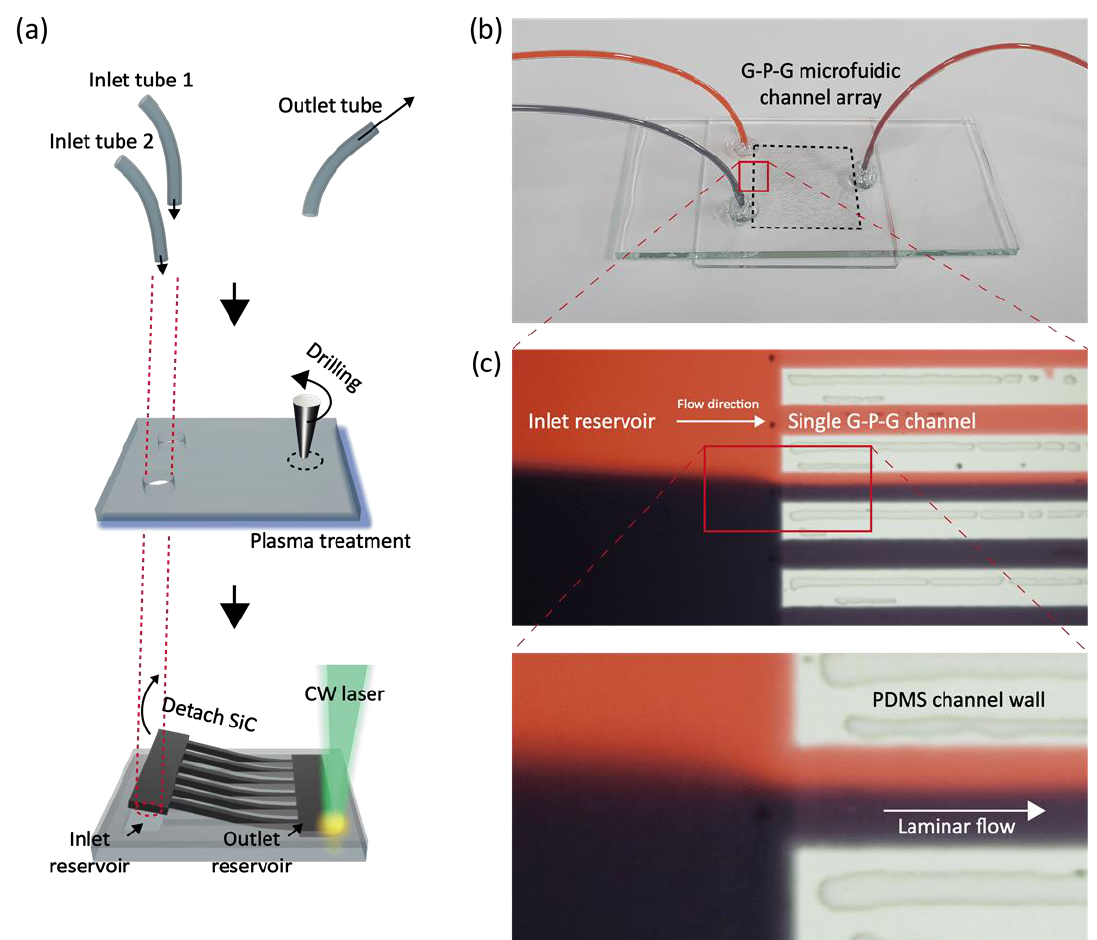
Figure 5. ( a ) concept illustration of microdevice fabrication, ( b ) microdevice images with tubes of inlet and outlet, ( c ) 20X magnified optical microscopy images of multiple channels showing laminar flow developed.